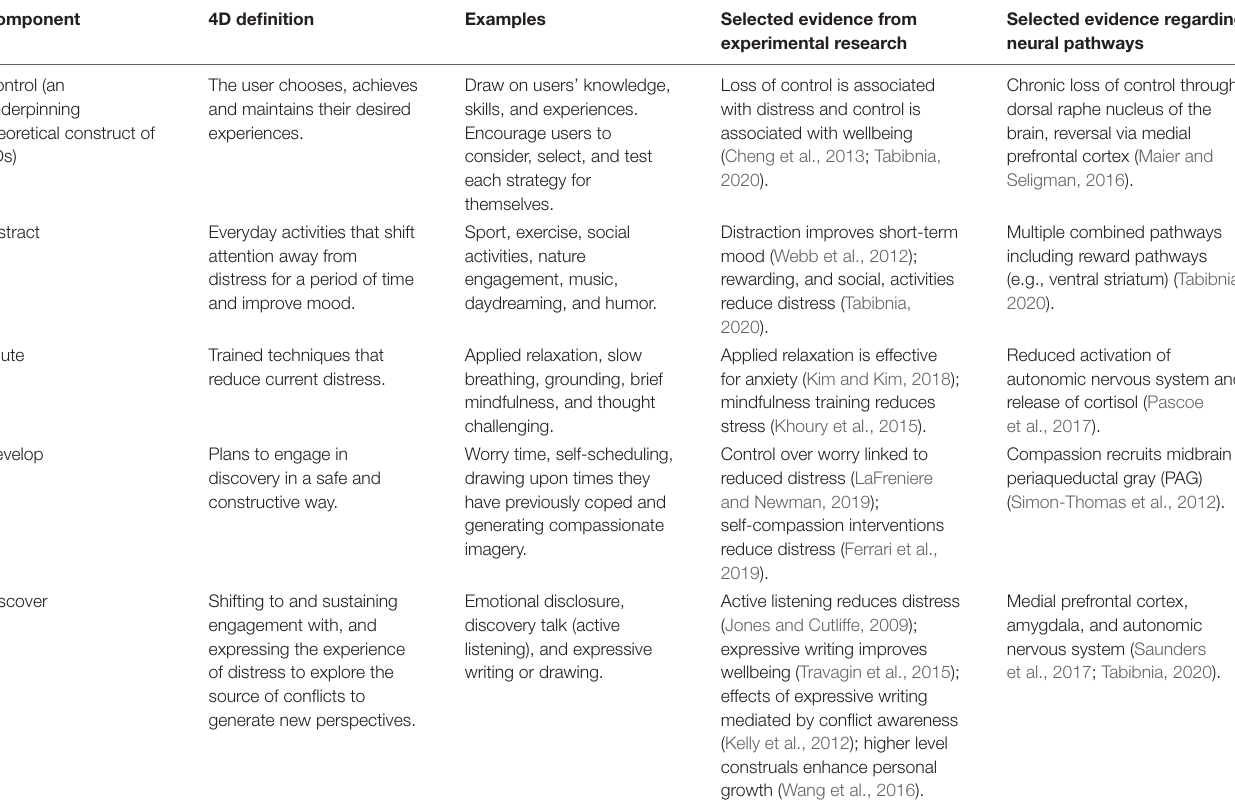
TABLE 1 | The components of 4Ds, their definition, examples, and